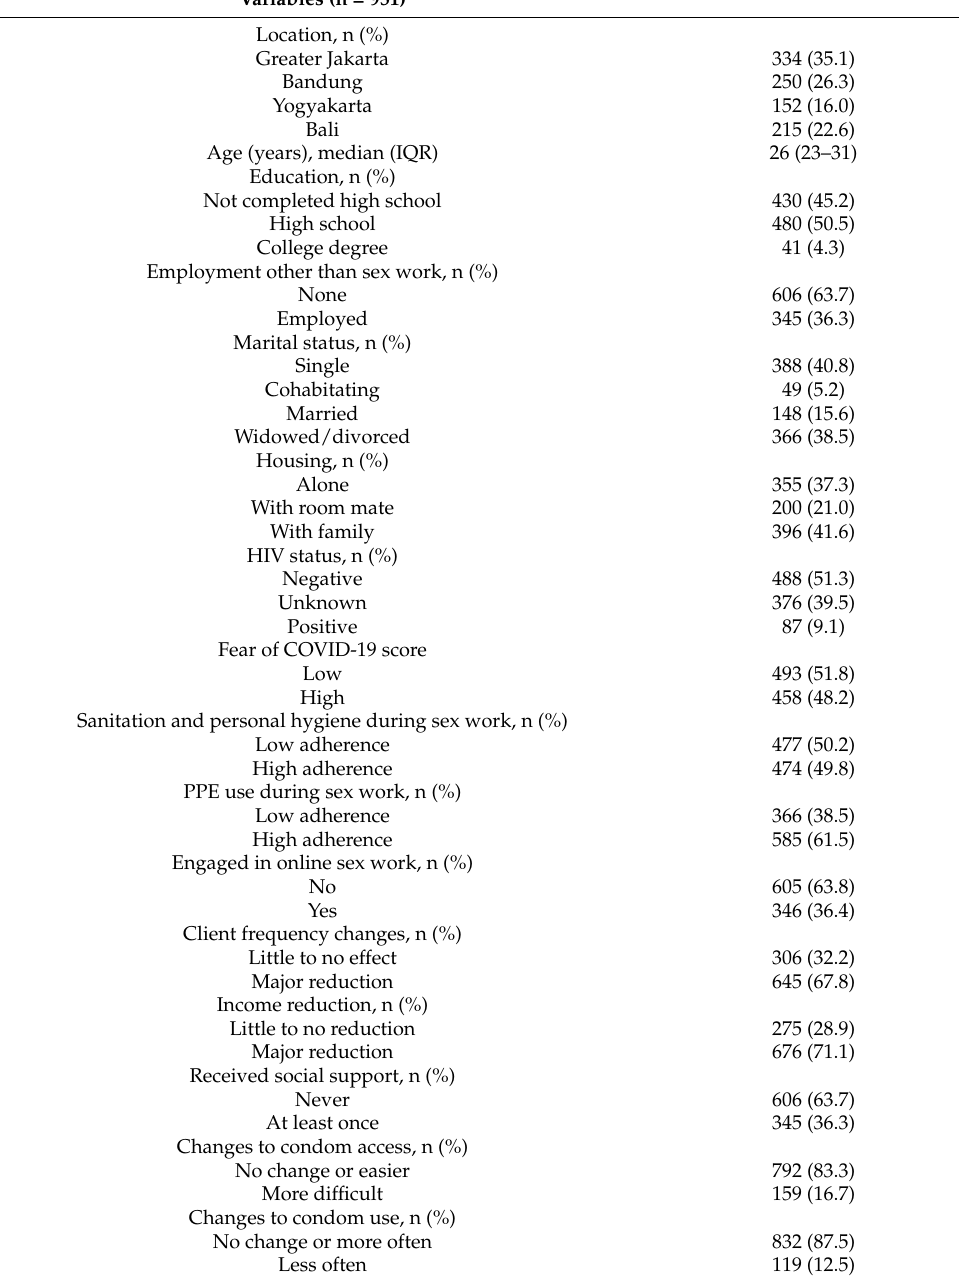
Table 1. Demographic and socioeconomic